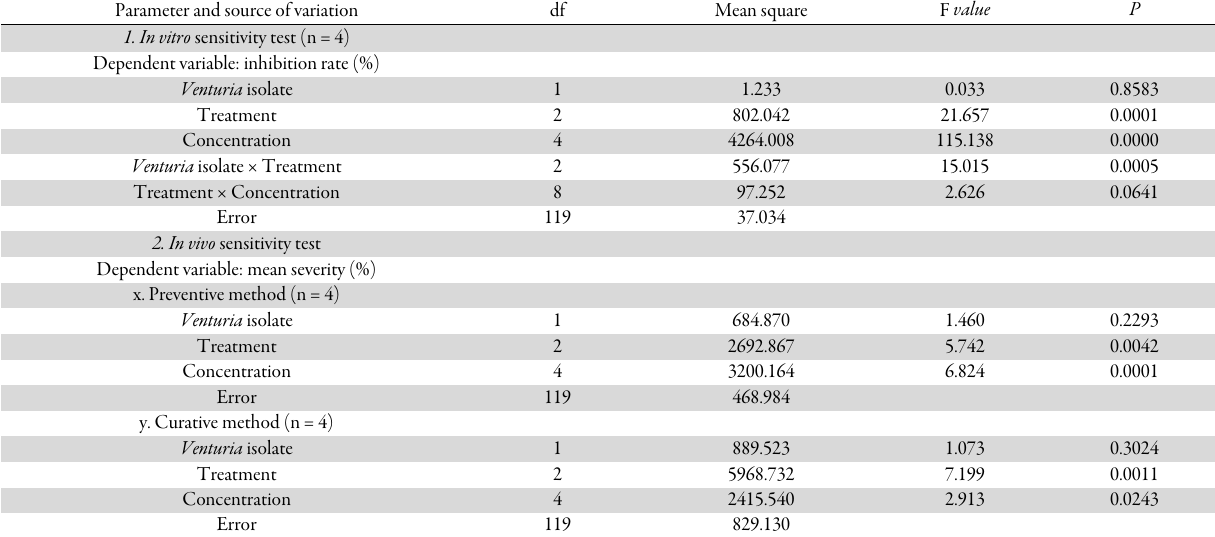
Table 4. Analysis of variance for the effects of Venturia isolates, fungicide treatments and concentrations on inhibition rate of mycelial growth and mean severity of detached